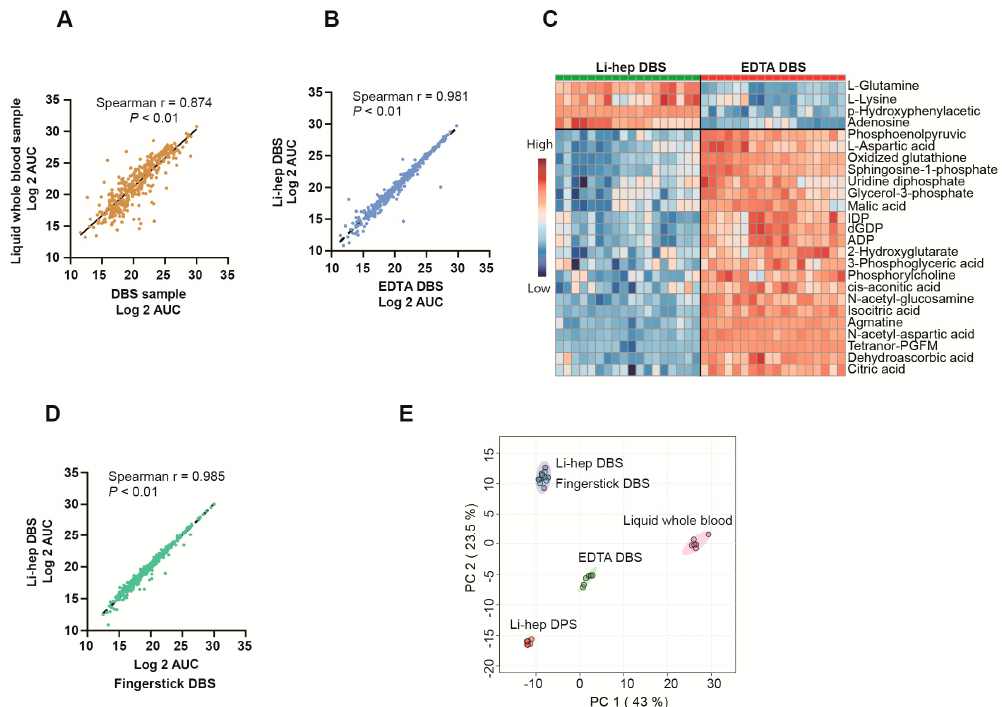
Figure 3. Sample type comparisons. ( A ) The correlations of areas under the curve (AUCs) of metabolites between wet blood and DBS. All 430 detected metabolites were used and the AUCs were log 2 transformed. The Spearman rank correlation was performed. The other correlation analyses